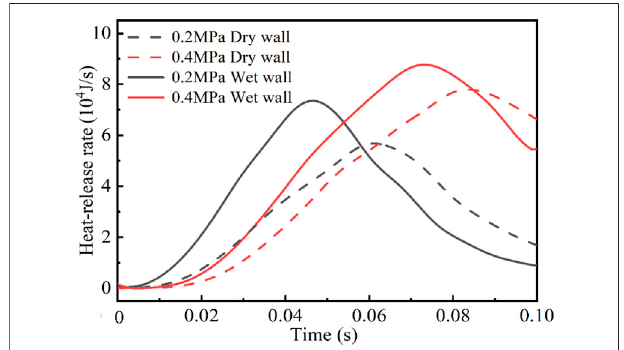
FIGURE 8 | Comparison of temperature variation and products distribution in the combustion chamber under dry and wet wall